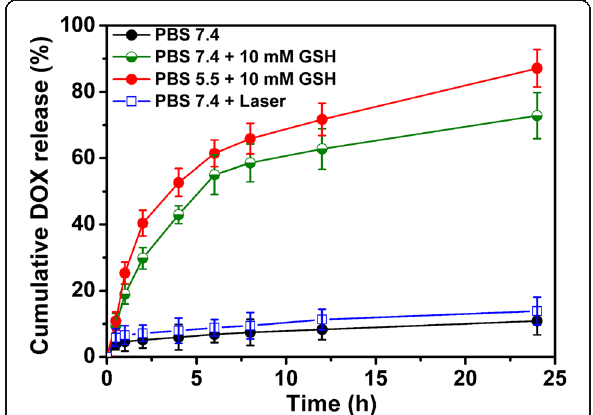
Fig. 6 DOX release profiles of PDA@PMAA-1 nanoparticles at 37 ° C in 7.4 phosphate buffer ( ○ ), in 7.4 phosphate buffer with NIR laser irradiation ( □ , in 7.4 phosphate buffer with 10 mM GSH (red circle), or in 5.5 phosphate buffer with 10 mM GSH (green